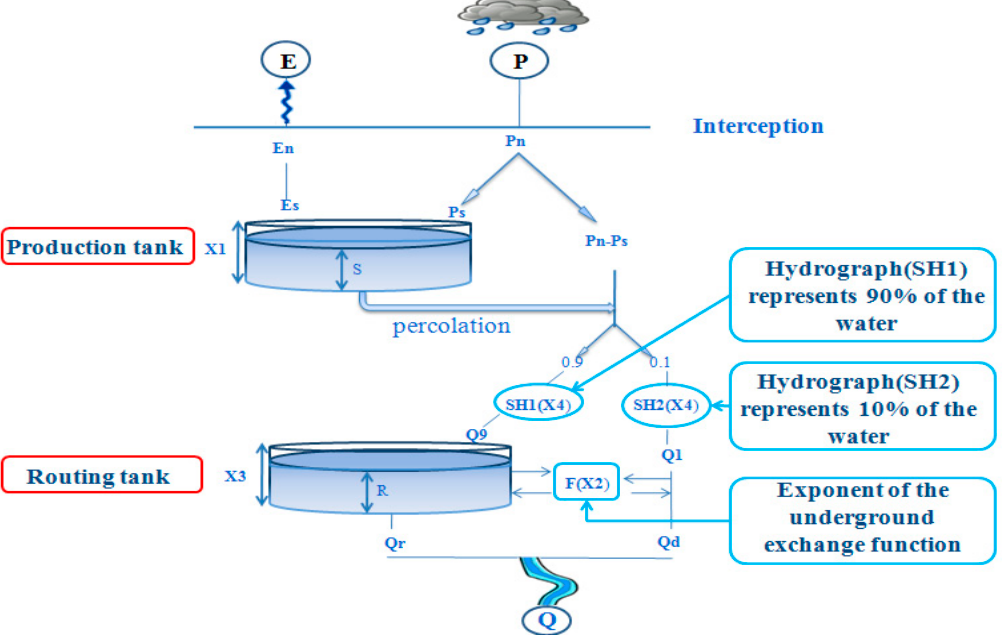
Figure 7. Structure diagram of the new version of the GR4J model.